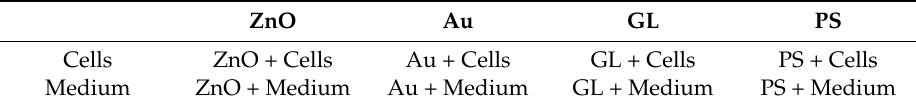
Table 2. MTT assays of a full factorial 2 × 4 design (ZnO nanowire arrays (ZnO), Au-coated cover glasses (Au), uncoated cover glasses (GL), and cell culture-treated polystyrene multi-well culture plates (PS)).